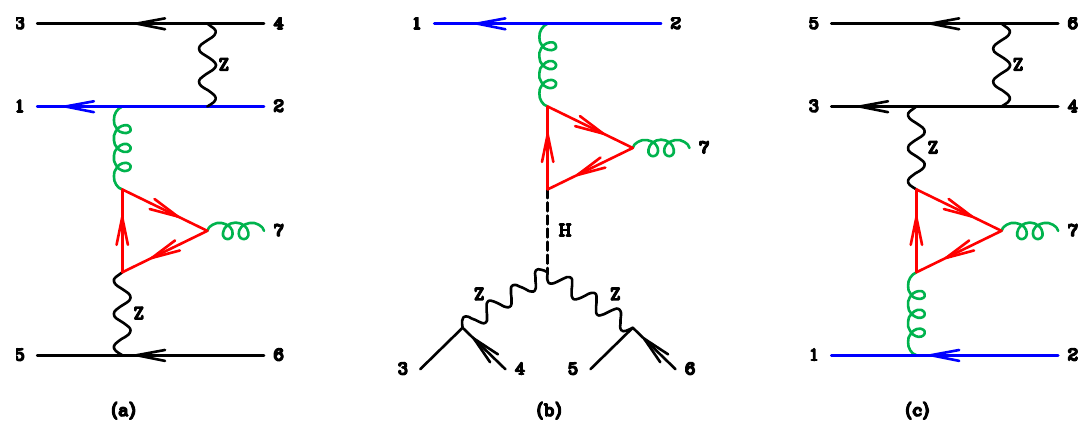
Figure 2 . Representative diagrams for additional processes (a) doubly resonant anomaly diagram; (b) Higgs boson contribution; (c) singly resonant anomaly